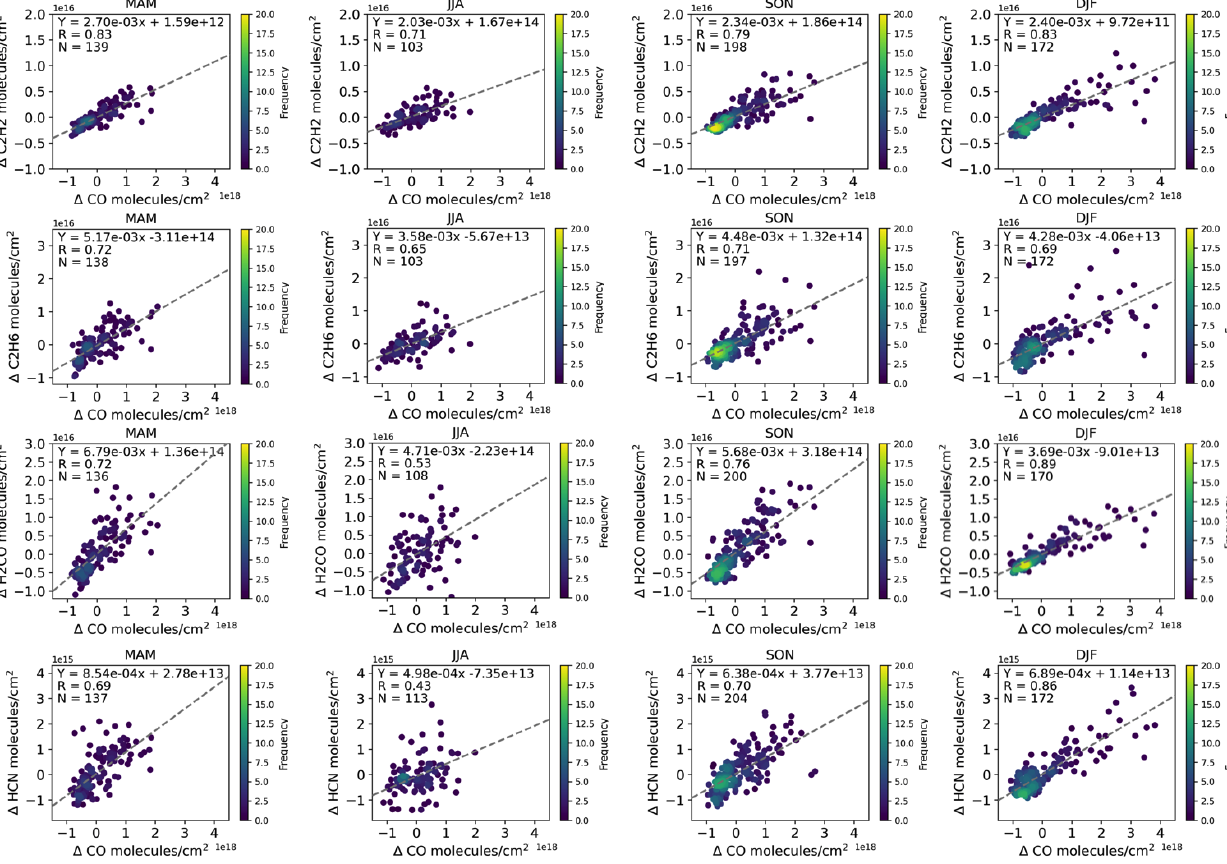
Figure 7. Similar to Fig. 6 but for the four seasons. Table 5. The settings of FLEXPART v10.4 backward simulation used in this